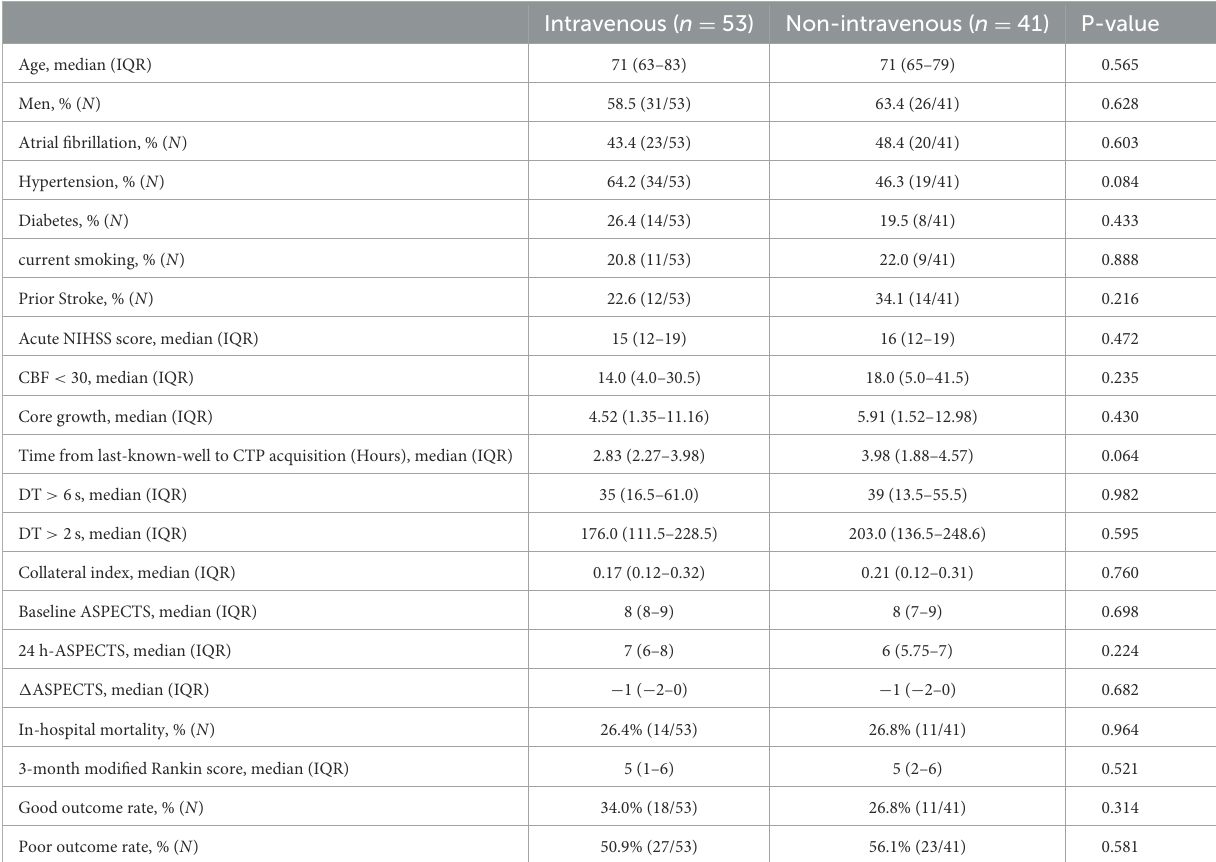
TABLE 1 Characteristics of the intravenous group vs. the non-intravenous group.